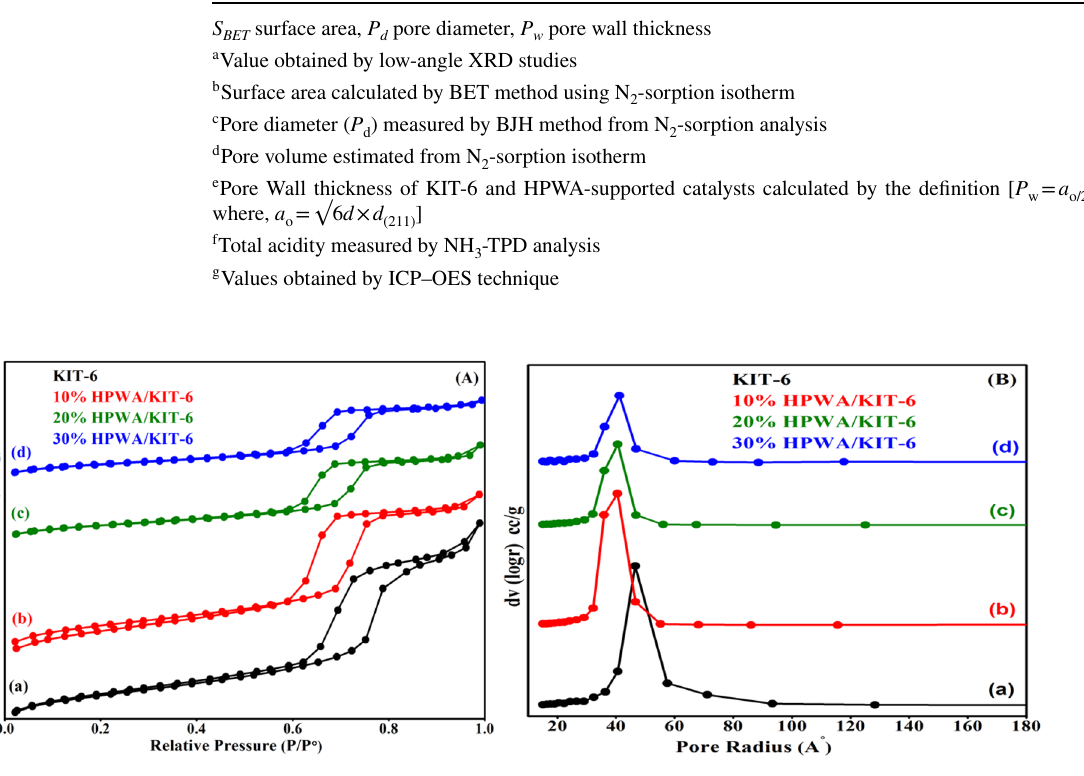
Fig. 2 a Nitrogen - sorption isotherm of KIT-6 and HPWA-supported catalysts. b BJH pore size distribution for KIT-6 and HPWA-supported